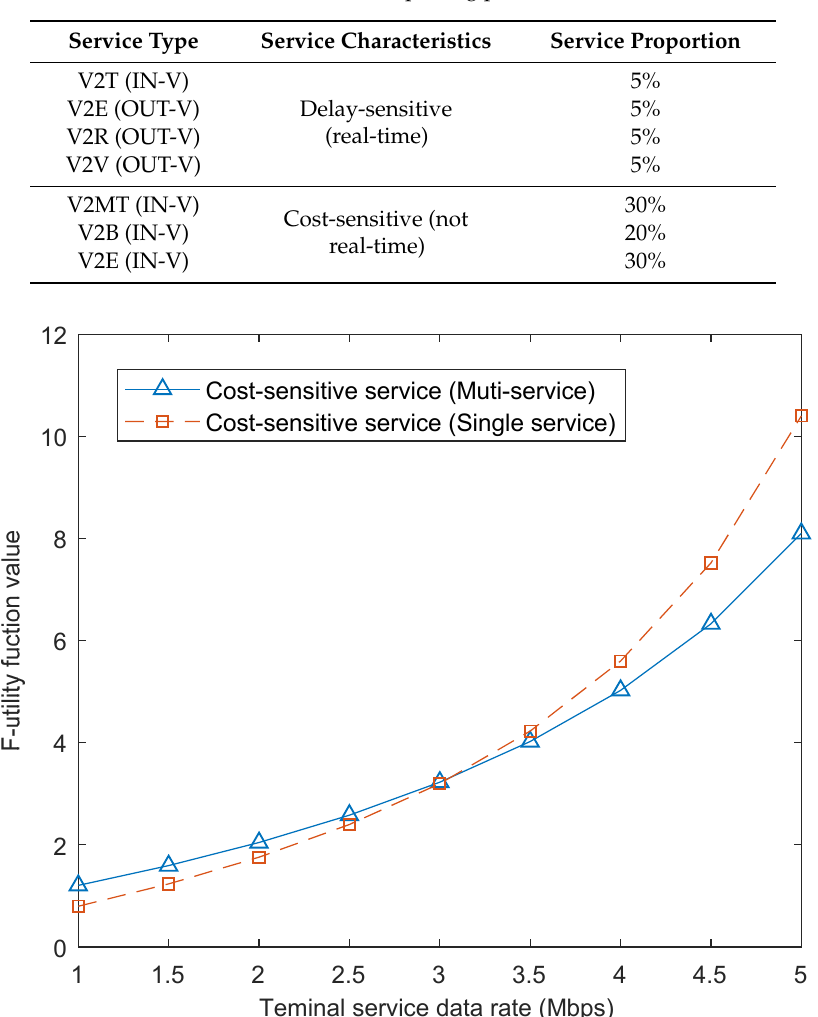
Figure 7. Delay-sensitive service utility value comparison results.